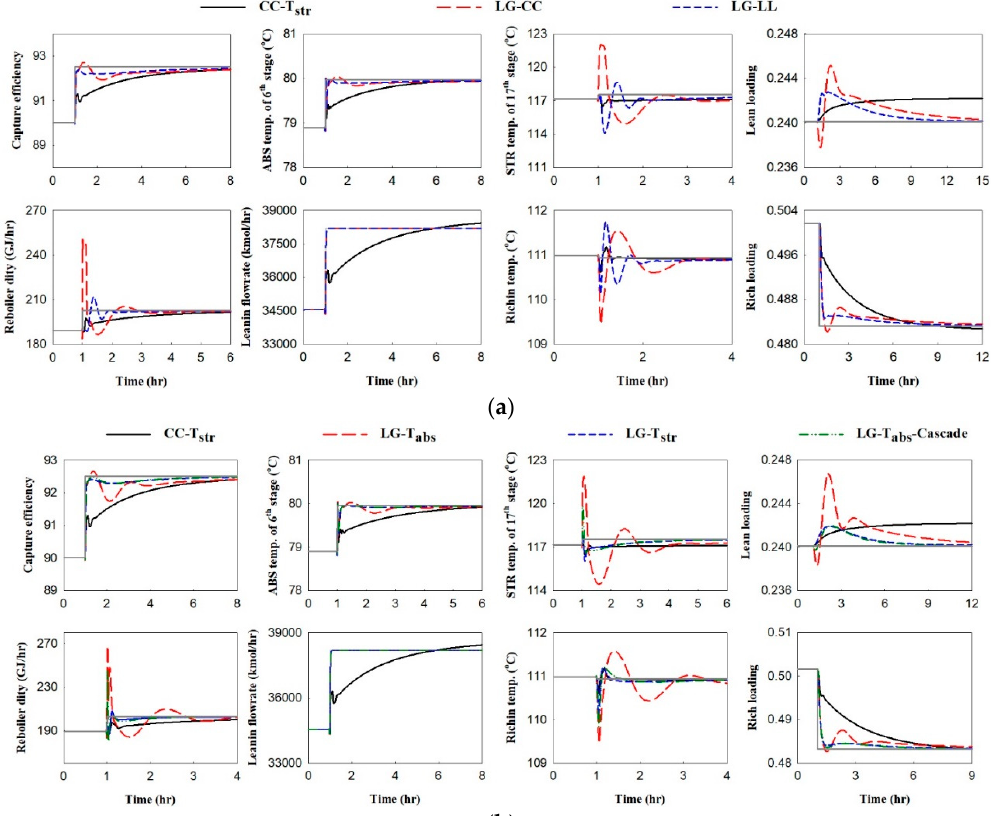
Figure 5. Dynamic responses for set-point change of CO 2 capture efficiency from 90% to 92.5%. The subfigures show the responses of the controlled variables (capture efficiency, lean loading, absorber temperature, and stripper temperature) and major process variables (lean solvent flow rate, reboiler duty, and the loading and temperature of the rich solvent). In both figures ( a ) and ( b ), the traditional control scheme (CC- T (cid:2929)(cid:2930)(cid:2928) ) responses are included for comparison. For all the control schemes, the new capture efficiency set-point can be met with the same reboiler duty at the new steady state. ( a ) concentration-control related schemes; ( b ) temperature-control related schemes.